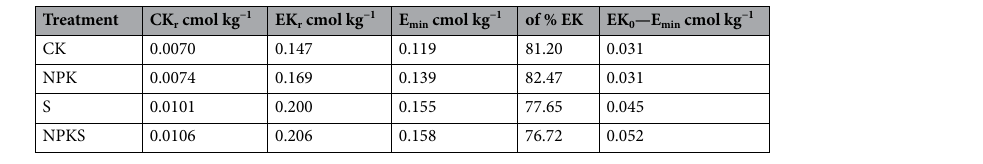
Table 6. Effect of long-term K fertilization on the critical value of solution K (CK r ), exchangeable K (EK r ) and minimum exchangeable K (E min ) of rice soil. CK, no fertilization; NPK, mineral fertilizing; S, straw 6000 kg h m −2 and NPKS, NPK with straw 6000 kg h m −2 . CKr, it can be obtained by dividing the intercept by slope of the regression equation of DNEK (in the y-axis) and CKf (x-axis) (Fig. 7); Ekr, it was obtained by interpolation from the relation EK f = f (CK f ) at CKr (Fig. 8), putting the value of CKr in the place of x, corresponding value of EK f was obtained, which is essentially